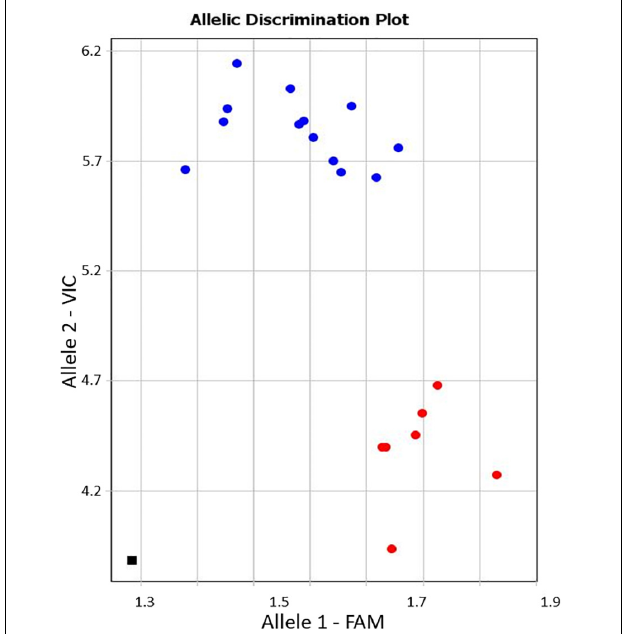
FIGURE 5 | An example of allele discrimination in the chickpea germplasm collection using the Amplifluor-like SNP marker KATU-C22. X - and Y -axes show Relative amplification units, (cid:49) Rn, for FAM and VIC fluorescence signals, respectively. Red dots represent homozygote ( aa ) genotypes with allele 1 (FAM), and blue dots represent homozygote ( bb ) genotypes for allele 2 (VIC) identified with automatic SNP calling. The black square shows the no template control (NTC) using water instead of template